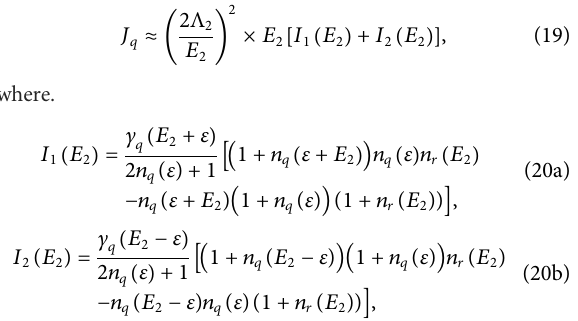
the modi fi ed qubit-resonator coupling strengths (5a) and (5 b) are speci fi ed as Λ 1 = 0 and Λ 2 (cid:1)